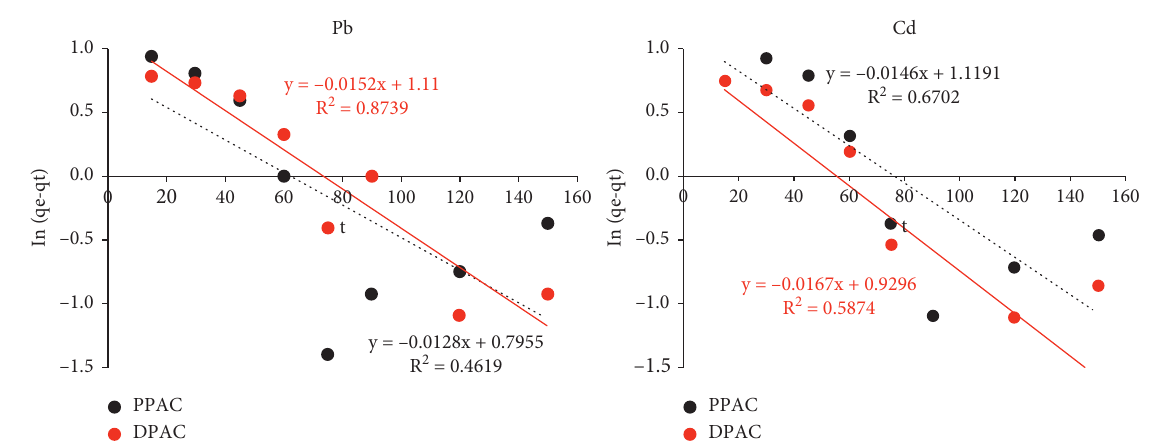
Figure 12: Pseudo-first-order reaction plots for Pb(II) and Cd(II) adsorption onto DPAC and PPAC.